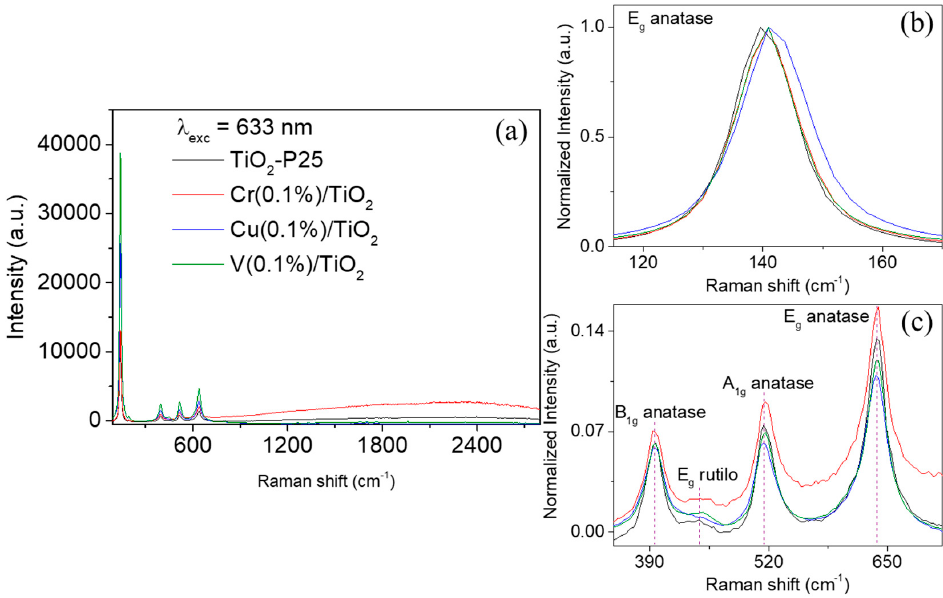
Figure 4. Raman spectra of air-dried non-impregnated TiO 2 (black spectrum), Cr(0.1%) / TiO 2 (red spectrum), Cu(0.1%) / TiO 2 (blue spectrum), and V(0.1%) / TiO 2 (green spectrum) sample on glass upon excitation at 633 nm laser line. ( a ) Full Raman spectra; ( b ) expanded spectral window from 110 to 170 cm − 1 , which a slight red-shift is observed on E g Raman mode at impregnated samples. This red-shift is slightly clearer on Cu(0.1%) / TiO 2 (blue spectrum). ( c ) Spectral window from 350 to 710 cm − 1 , showing that A 1g peak of anatase is slightly shifted and broadened in impregnated samples. Raman spectra shown in ( b ) and ( c ) were normalized at maximum intensity of E g Raman band for the sake of